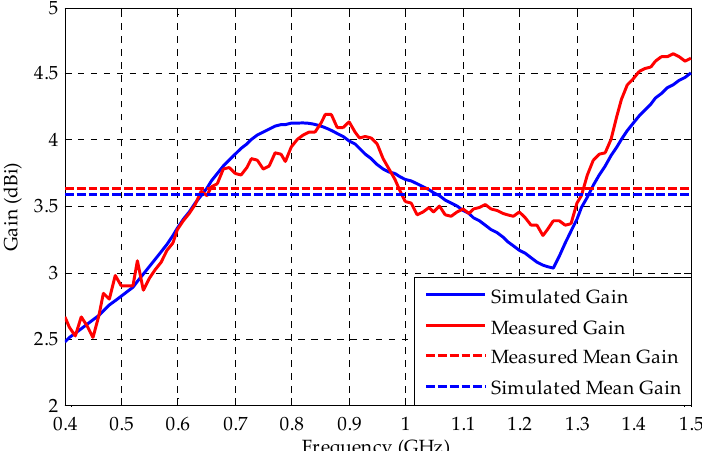
Figure 14. Comparison between the measured and simulated gain and their respective calculated mean gain for the bio-inspired PMA.